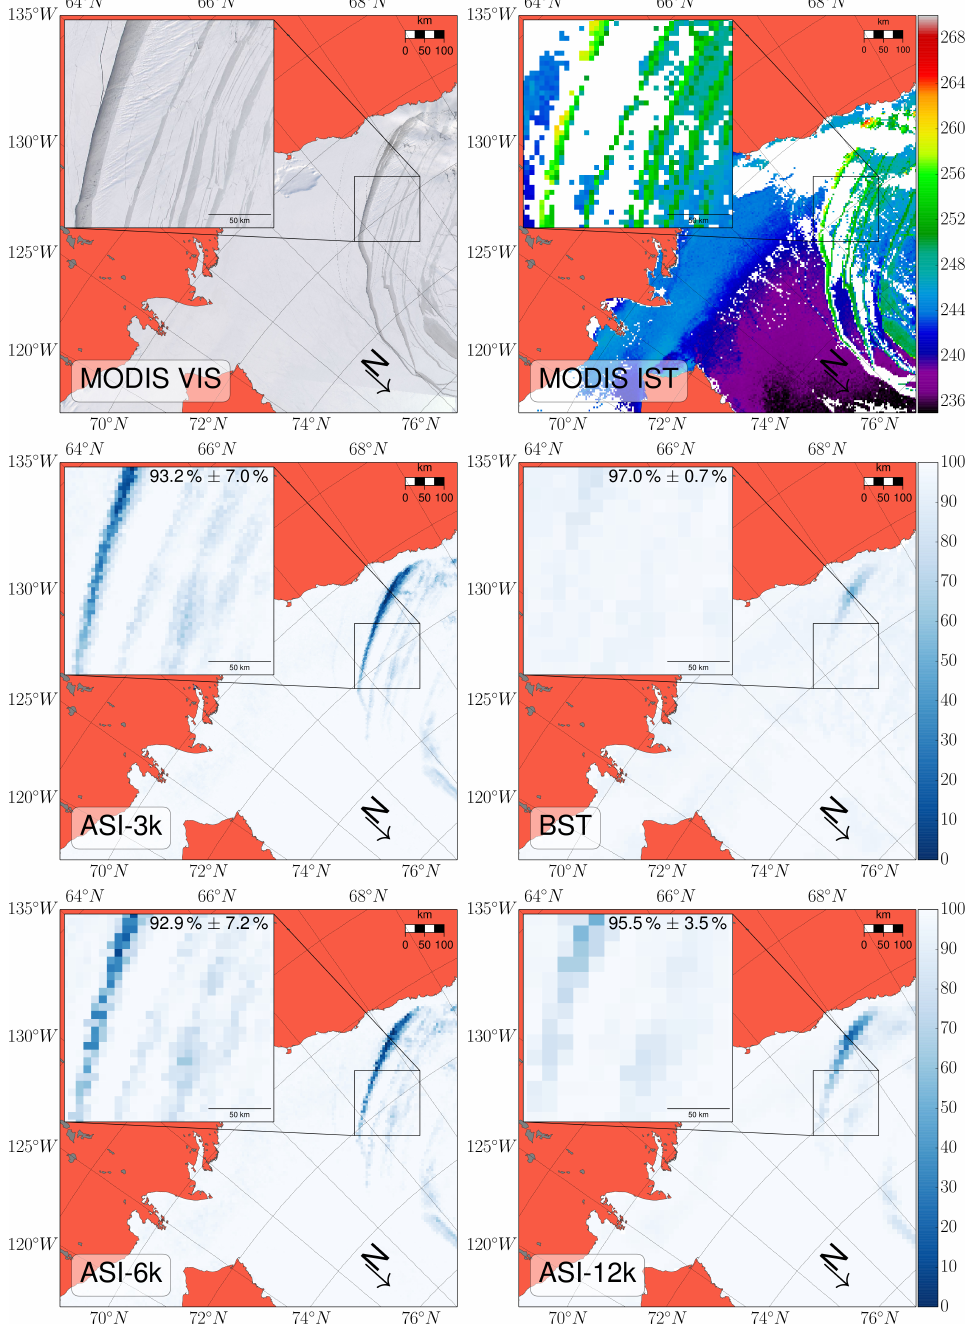
Figure 2. Comparison of 250-m MODIS True Color (MODIS VIS), 4-km MODIS ice surface temperature (MODIS IST), ASI-3k, ASI-6k, ASI-12k and Bootstrap (BST) sea ice concentrations (SIC) for 26 February 2013. All maps display a part of the southern Beaufort Sea, with the Canadian and Alaskan coasts in the upper and left parts of the maps. The northern tip of Banks Island can be seen at the lower margin of the maps. An image inset with a zoom of a specified region (170 km × 170 km ) is placed on the continental areas for a closer examination of the individual data sets. An arrow depicts the direction to the North Pole. The white areas in MODIS IST depict missing